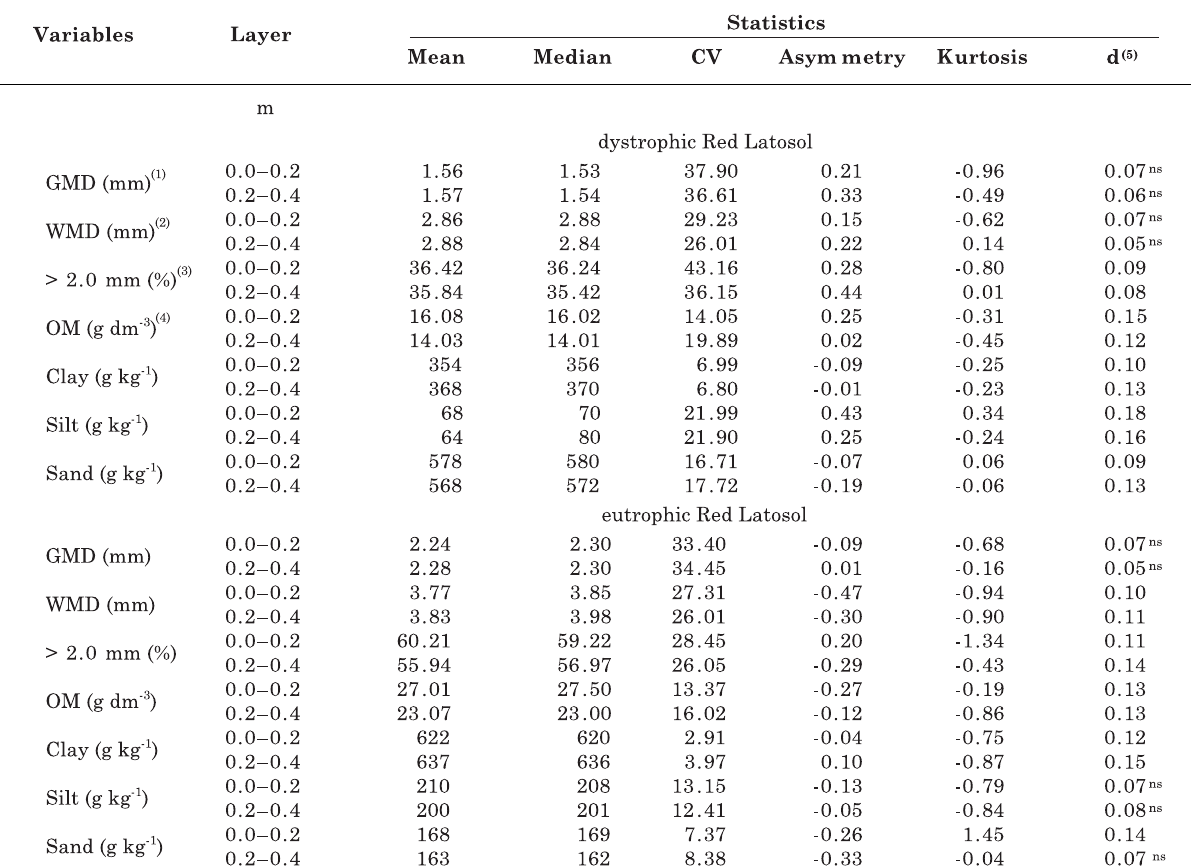
Table 1. Descriptive statistics for the variables geometric mean diameter, mean weight diameter, aggregates in class > 2.0 mm and organic matter proportion, in an eutrophic Red Latosol and a dystrophic Red Latosol in layers of 0.0–0.2 and 0.2–0.4